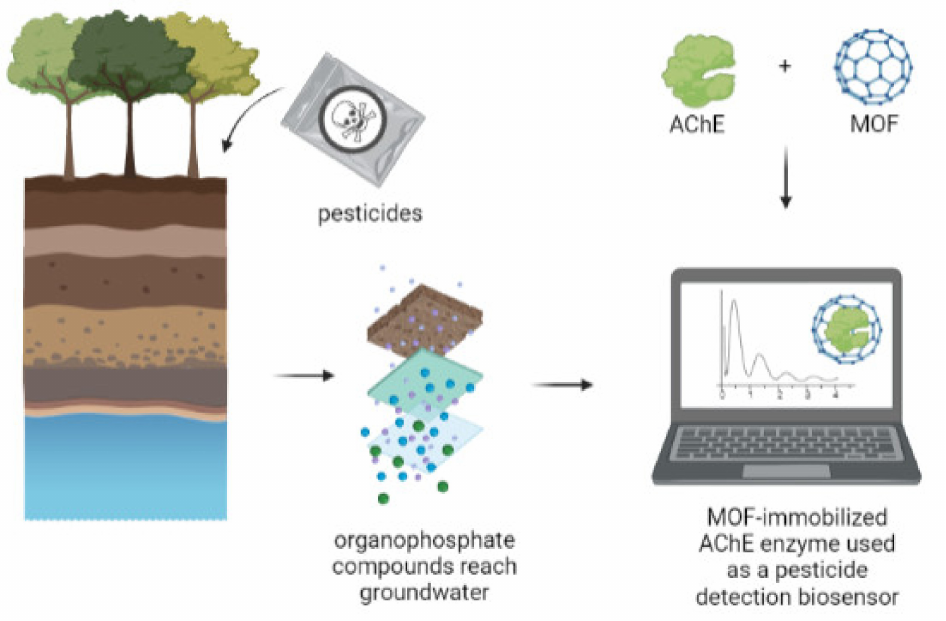
Figure 12. The identification protocol of organophosphate pesticides that is widely used in the agricultural industry. These pesticides are capable of permeating the soil and reaching groundwaters causing pollution; they can be detected with an AChE-MOF biosensor.